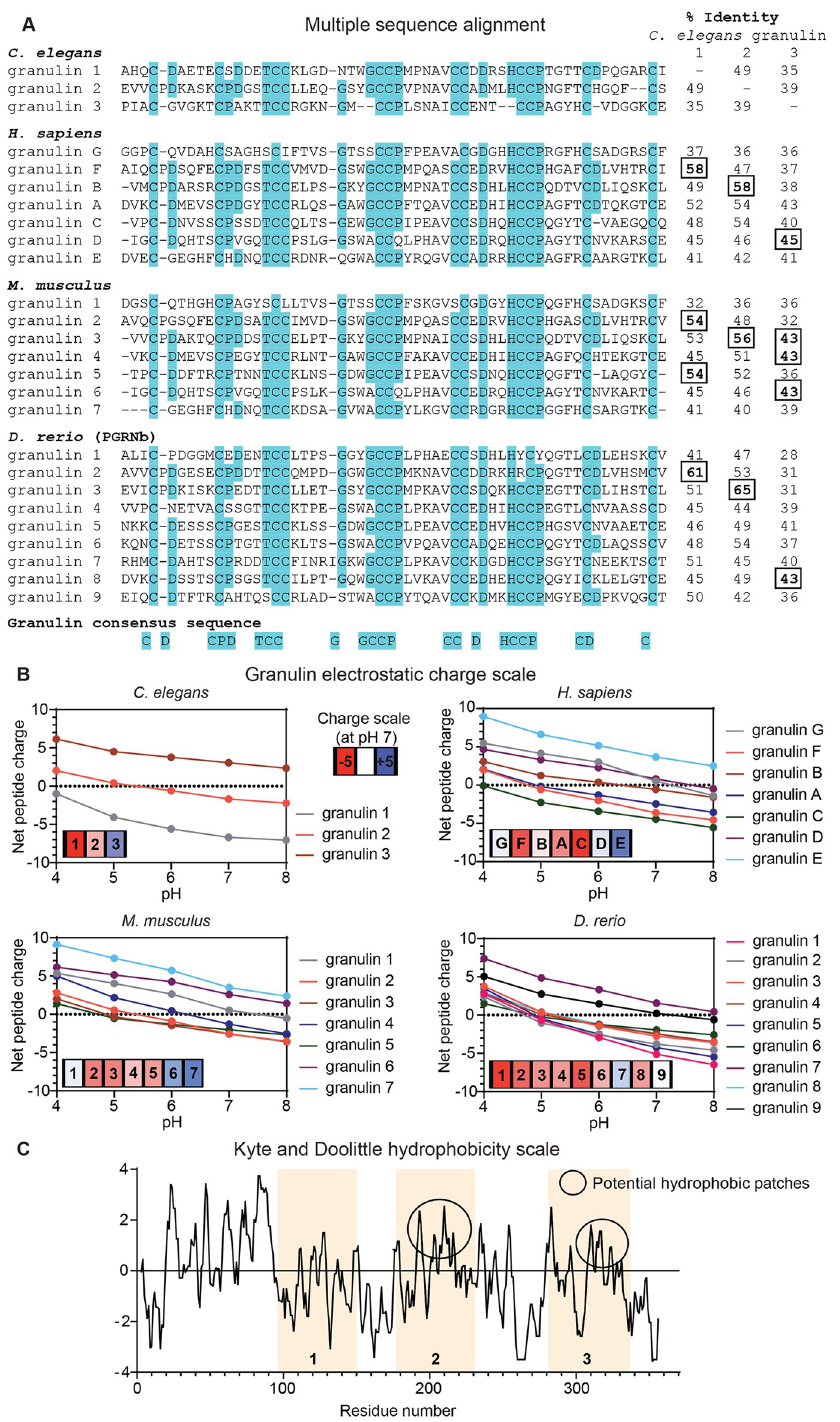
Fig 5. Computational analysis of granulin sequence across species highlights their distinct electrostatic and hydrophobicity profiles. ( A ) Amino acid multiple sequence alignment for C . elegans , Homo sapiens , Mus musculus and Danio rerio (PGRNb) granulin domains using the MAFFT (Multiple Alignment using Fast Fourier Transform) server. Residues matching the granulin consensus sequence are highlighted in cyan. The identity score (%) between all granulin domains and C . elegans granulins 1, 2 and 3 from pairwise sequence alignment using the EMBOSS Needle server is indicated on the right. The granulin domains of different species sharing the highest identity score to C . elegans granulins 1, 2 and 3 are highlighted in square boxes. ( B ) pH-dependent electrostatic charge scale calculated